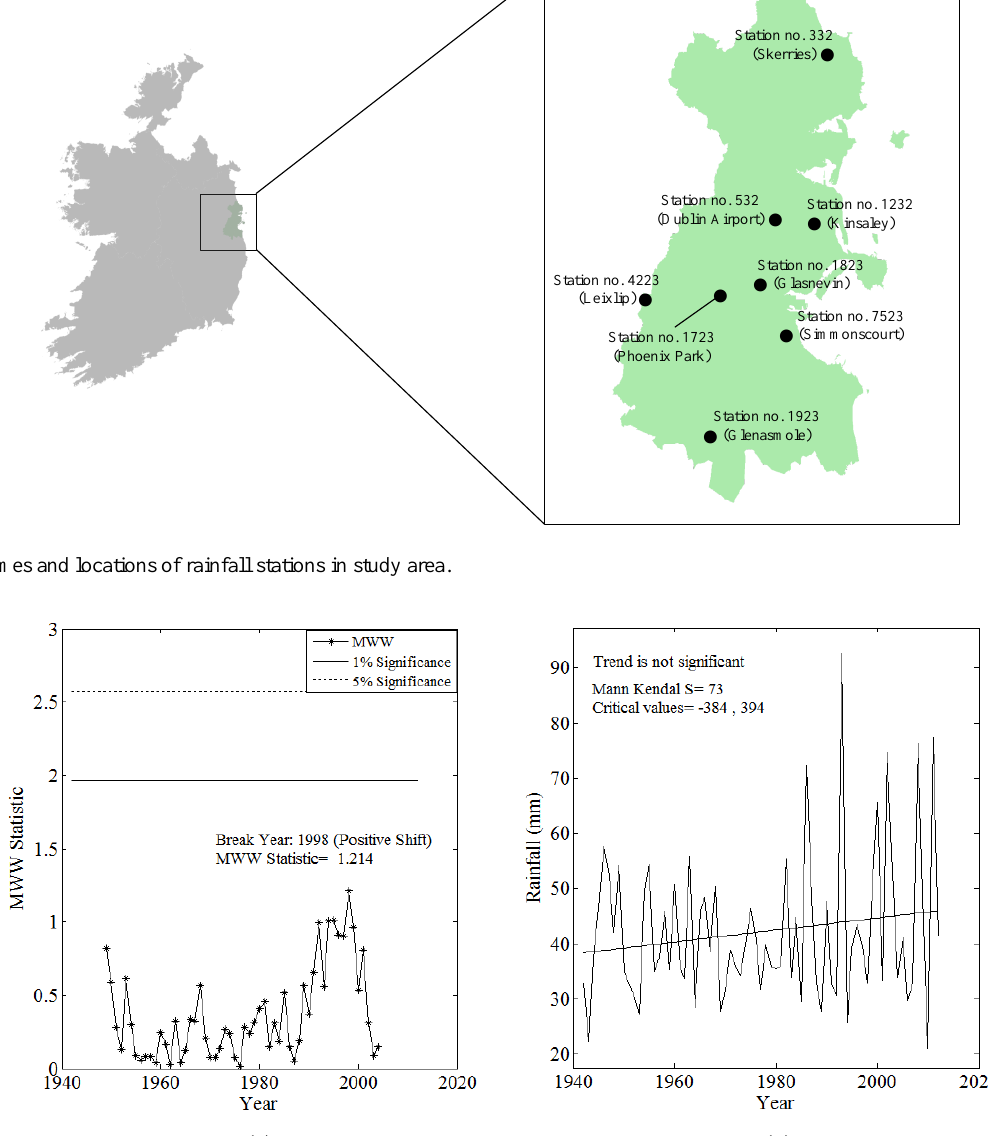
includes depth frequency relationships derived using a